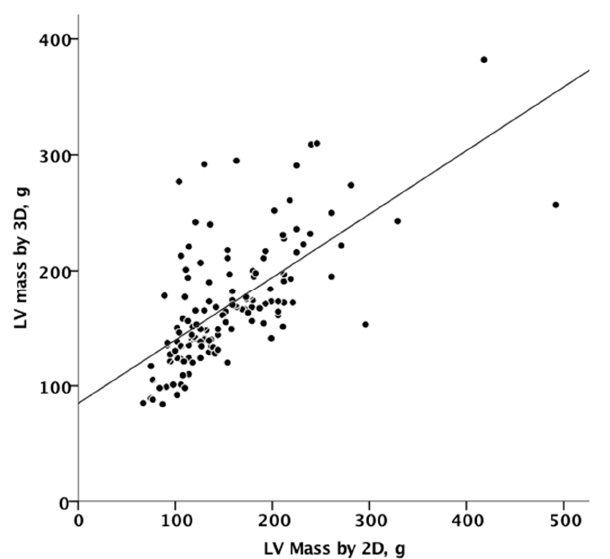
Figure 3. Linear correlation between 2D and 3D measurements of mass. 2D, two-dimensional; 3D, three-dimensional.